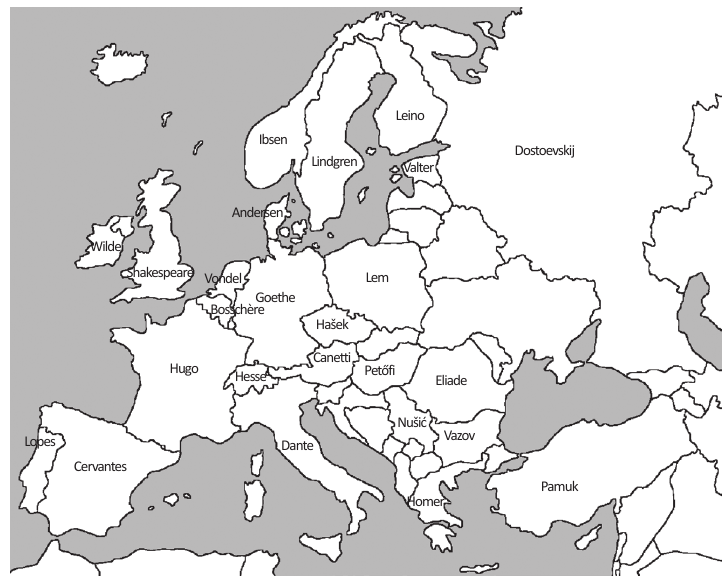
Abbildung 3. Die am häufigsten genannten Autoren zu den 25 “sichtbaren” Ländern auf der litera- rischen Karte Europas aus der Sicht der befragten bulgarischen